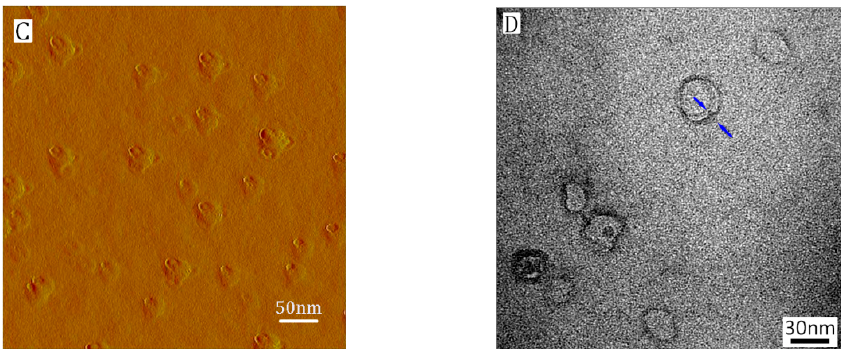
Figure 3. Absorption spectrum of PIC-@-Au 20 NPs throughout time upon addition of 0.1 g/mL KCN ( A ). Hydrodynamic diameter distributions ( B ). AFM image ( C ), and TEM image ( D ) of PICsomes 20 .